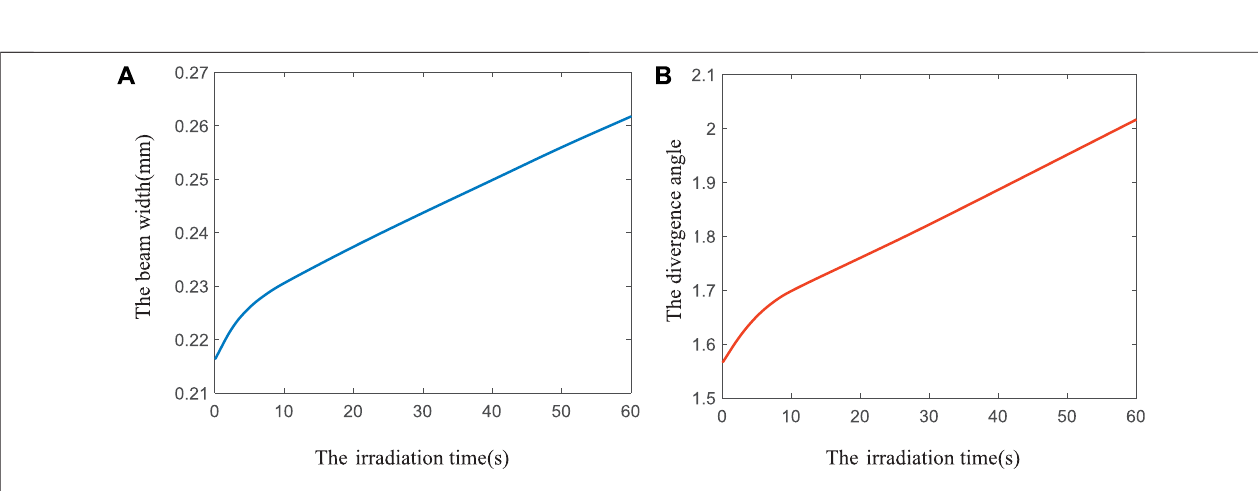
FIGURE 13 | The curve of beamwidth and divergence angle of the combined beam with the irradiation time: (A) beamwidth; (B) divergence angle.